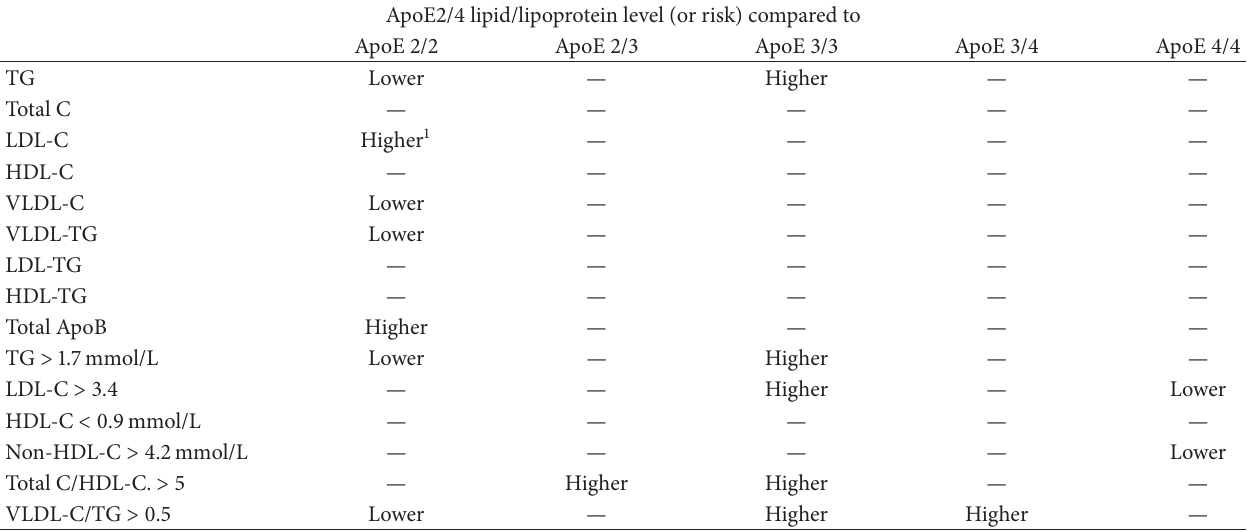
Table 4: Summary of the main